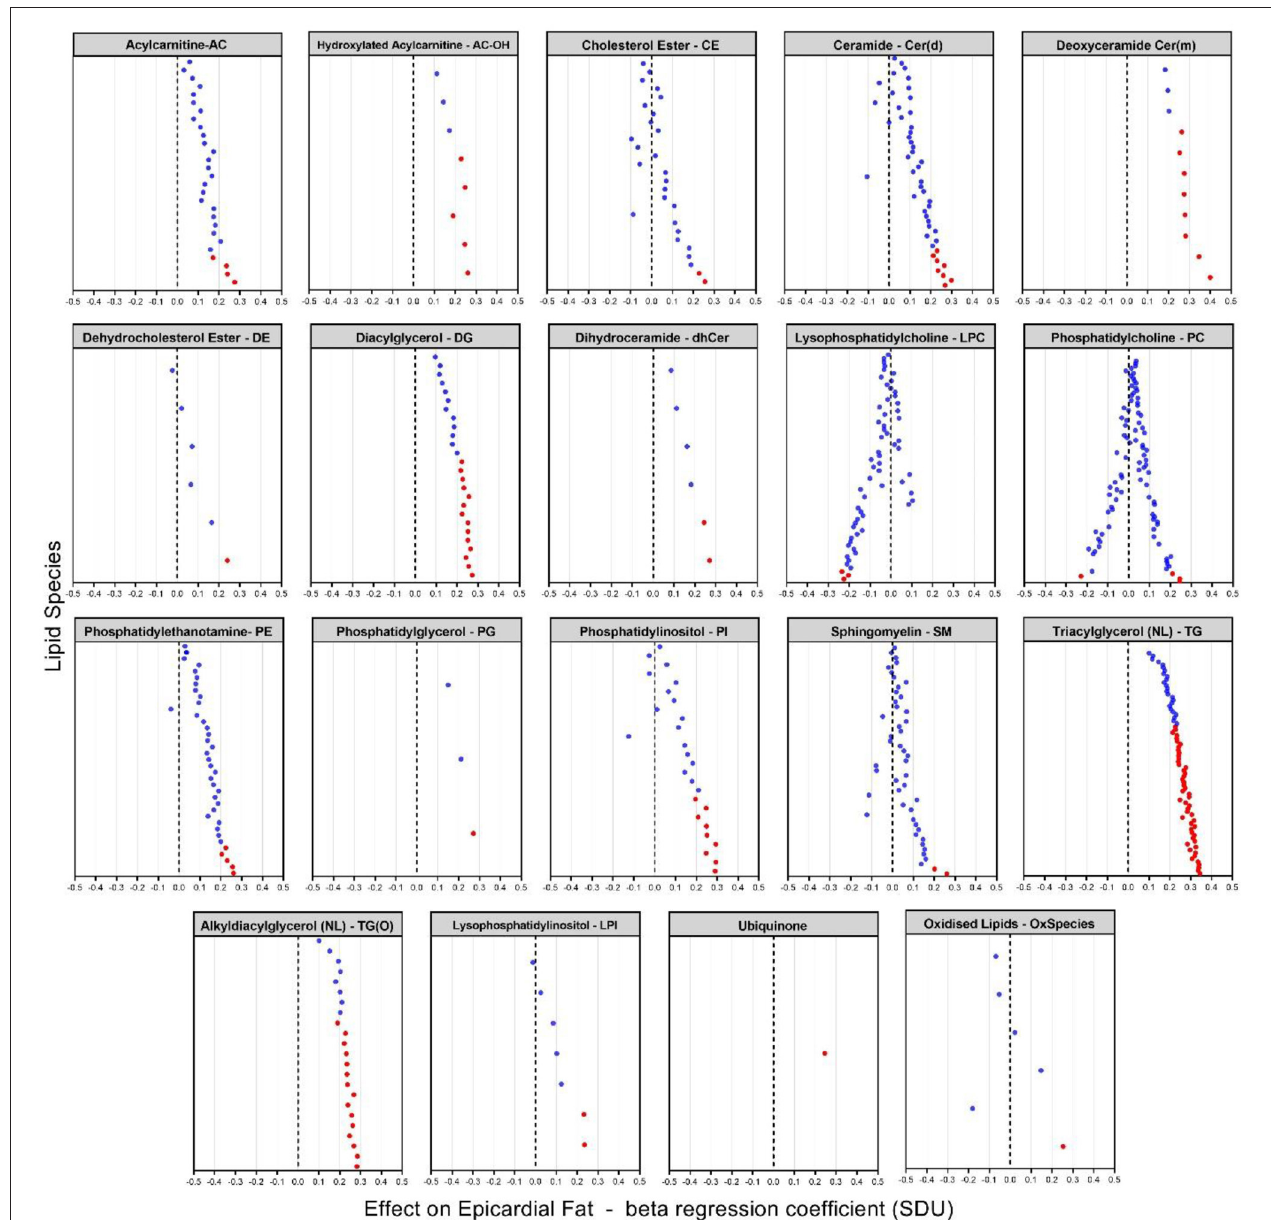
FIGURE 3 | Plasma lipidome associations with EAT volume [beta coefficient of regression (SDU)]. The figure shows significant increases and decreases in lipid levels in 19 classes of lipids with species having an FDR < 0.05 (indicated by the red dots). Each dot represents a lipid species within the specific lipid